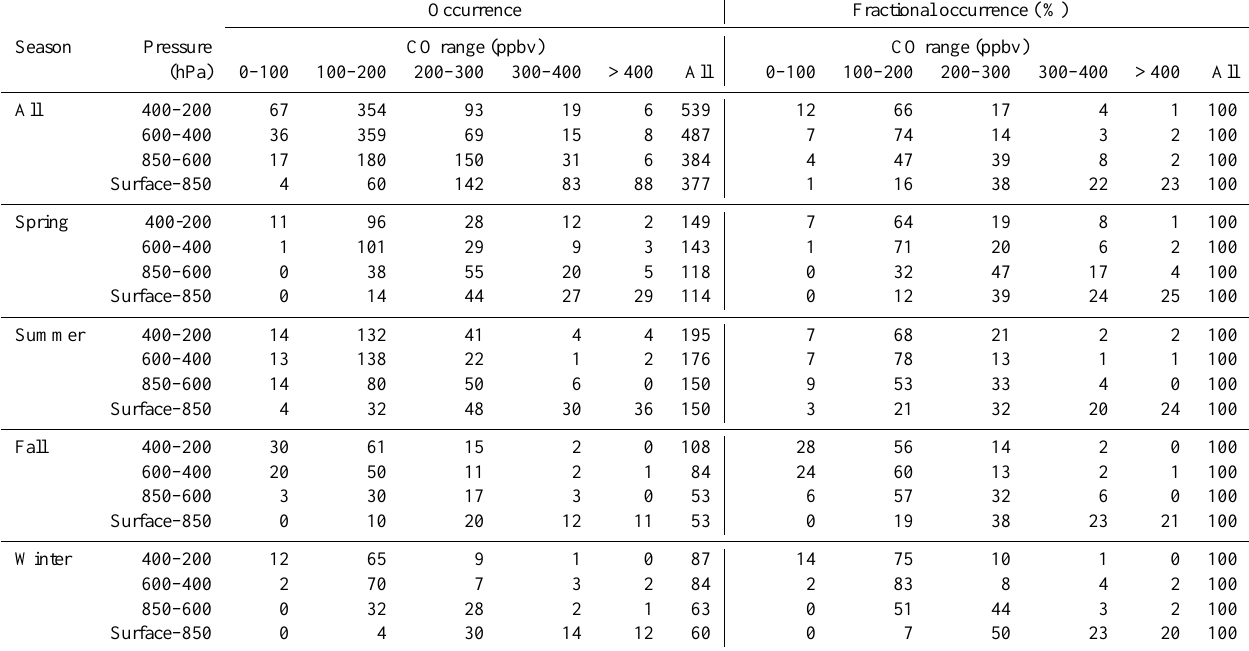
Table 2. Occurrences of various CO ranges at different altitudes in the MOZAIC measurements in the vicinity of Narita from 2001 to 2006. Occurrence Fractional occurrence